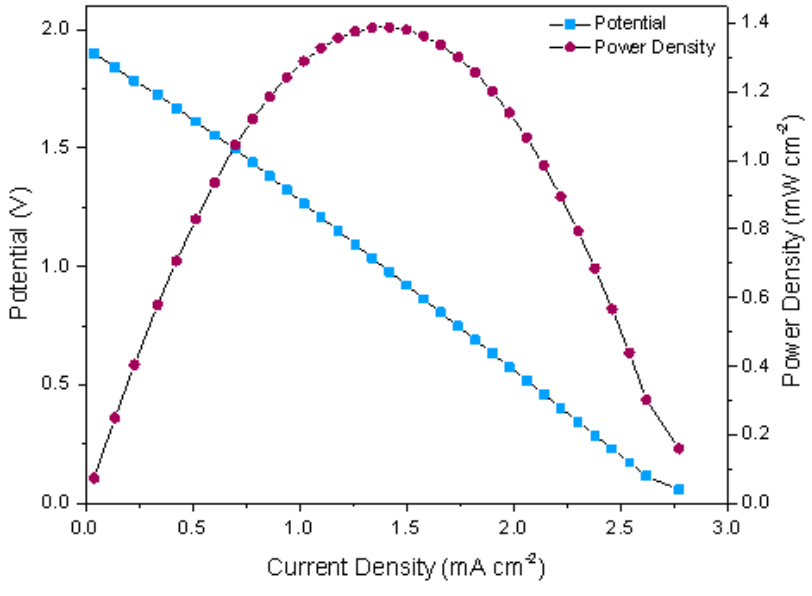
Figure 6. Polarization and power density curves of the air-breathing paper-based µFC stack with TiO 2/ Ni anode and Pt/C cathode outside the digital pregnancy test using human urine as